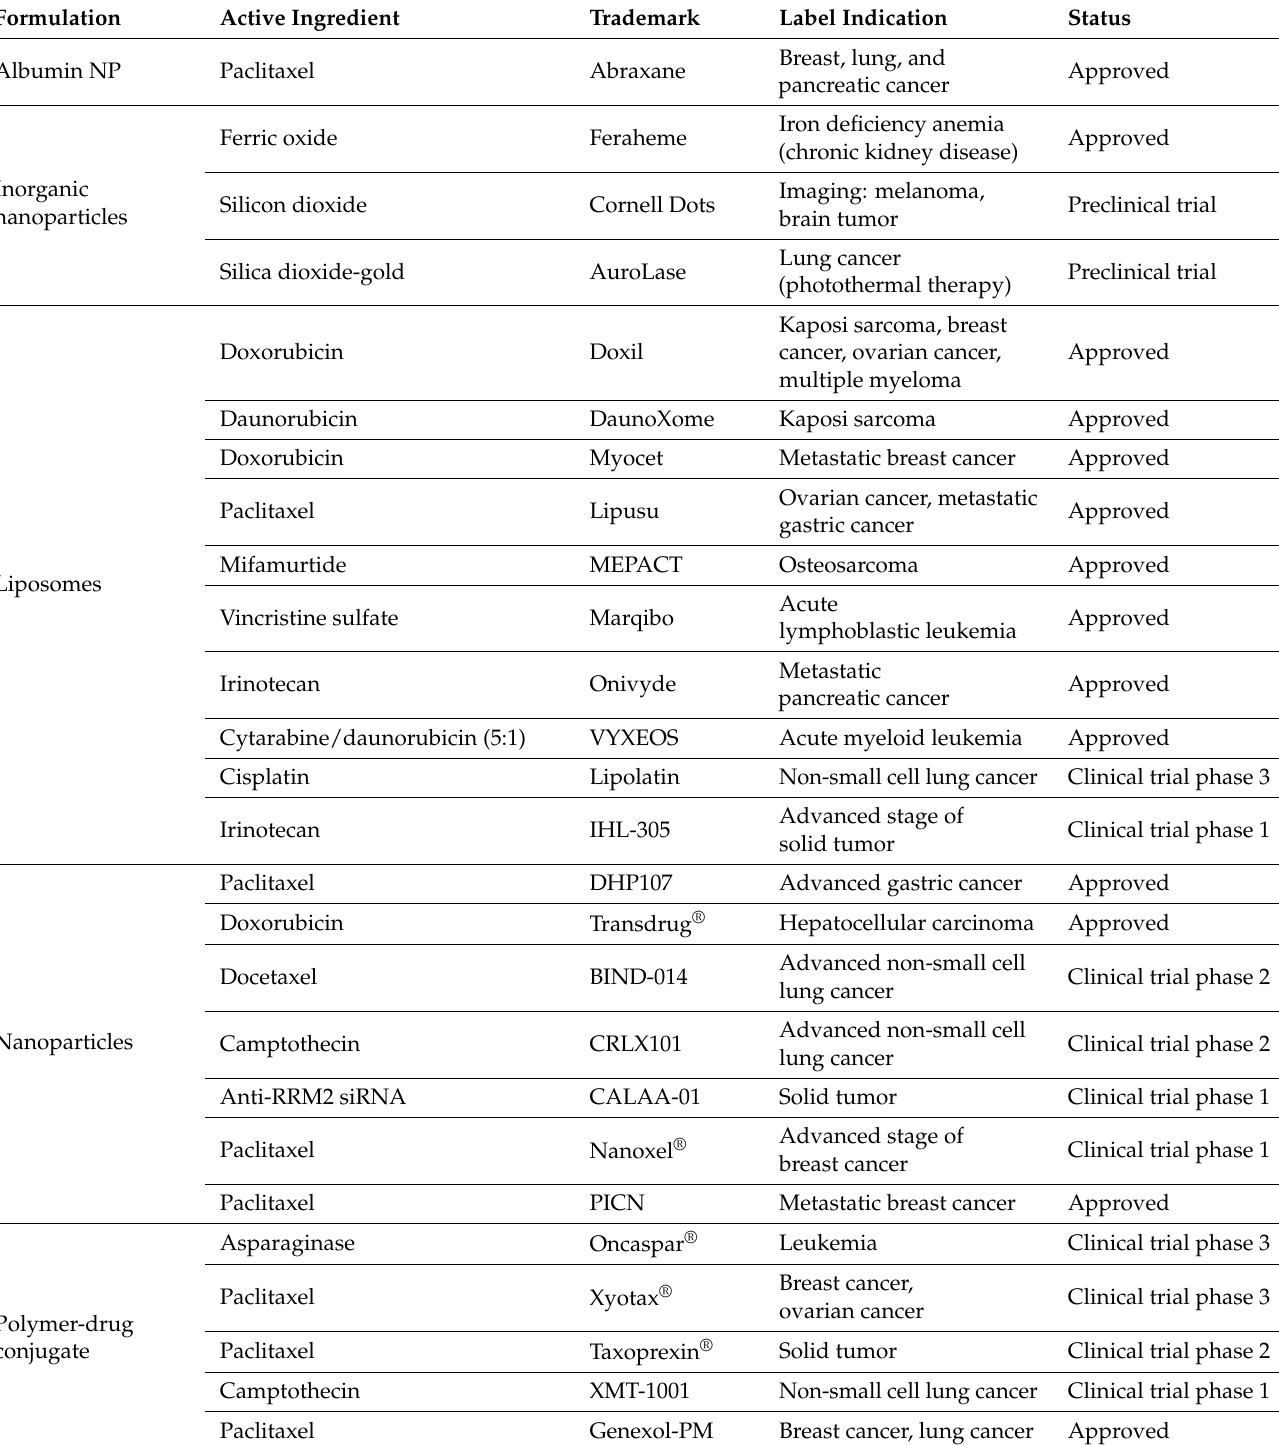
Table 1. Functional nanoparticles in clinical